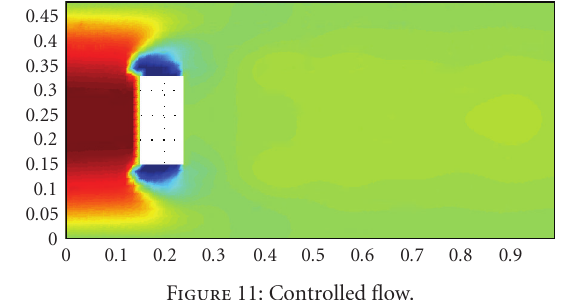
Figure 11: Controlled